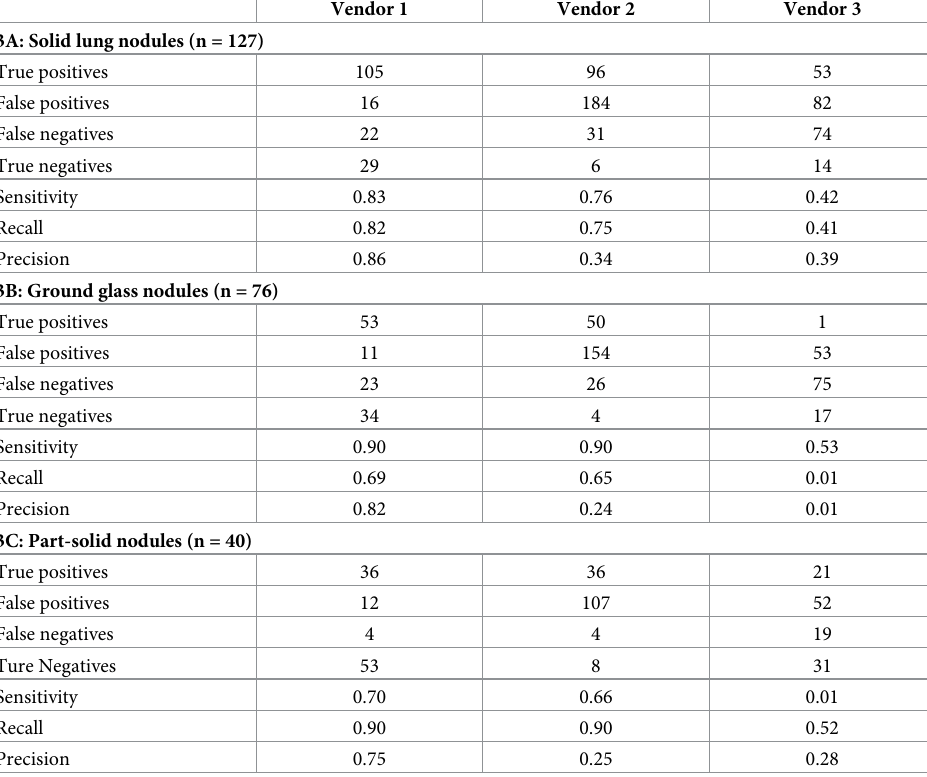
Table 3. Stratified summary statistics of three AI algorithms for detection of solid (3A, n = 127), ground glass nodules (3B, n = 76), and part-solid (3C, n = 40) lung